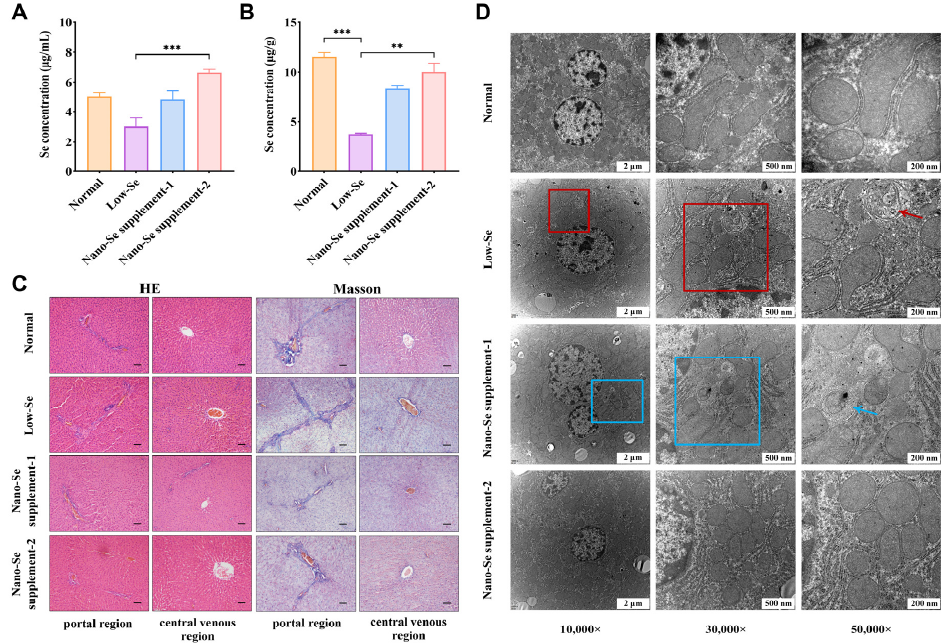
Figure 1. Results of animal experiments after the 12-week intervention. ( A ) Se concentrations of rat serums in different groups. *** p < 0.001. ( B ) Se concentrations of rat livers in different groups. ** p < 0.01, *** p < 0.001. ( C ) Representative HE and Masson staining results in the liver’s portal and central venous regions. Scale bar: 200 µ m. ( D ) TEM observations of ultrastructural changes in livers. Compared with the normal group, the malformed mitochondria ( (cid:3) ) and typical mitophagy phenomenon ( → ) were observed in the low-Se group. There was mild swelling of mitochondria ( (cid:3) ) and typical mitophagy phenomenon ( → ), but the number was significantly reduced compared with the low-Se group. Se: